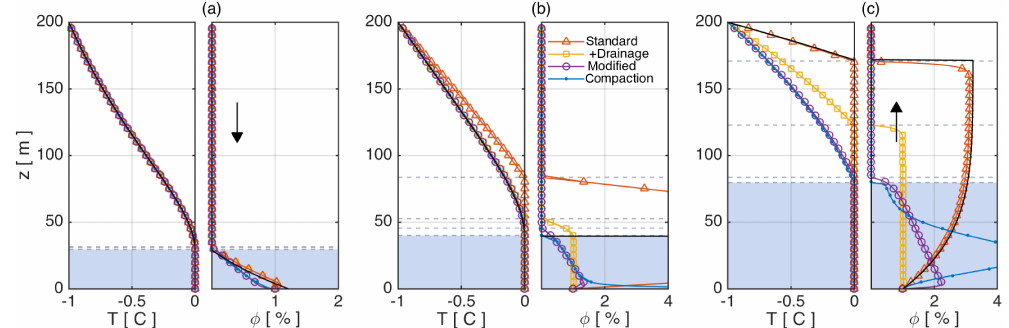
Figure 2. Steady-state solutions for the parallel-sided slab, showing temperature and porosity as a function of height. Normal velocities are (a) w = − 0 . 2myr − 1 , (b) w = 0myr − 1 , and (c) w = 0 . 2myr − 1 . In each case, orange triangles show the standard enthalpy gradient method, yellow squares show the standard enthalpy gradient model method with drainage, purple circles show the modified enthalpy method, and blue dots show the compaction pressure model. Solid black lines show the semi-analytical solutions for the case of no relative water transport. Shading shows the region of temperate ice for the compaction pressure model. Parameter values are as in Table 1, together with H = 200m, S = sin4 ◦ , T s = − 1 ◦ C, T m = 0 ◦ C, and φ m = 1%.